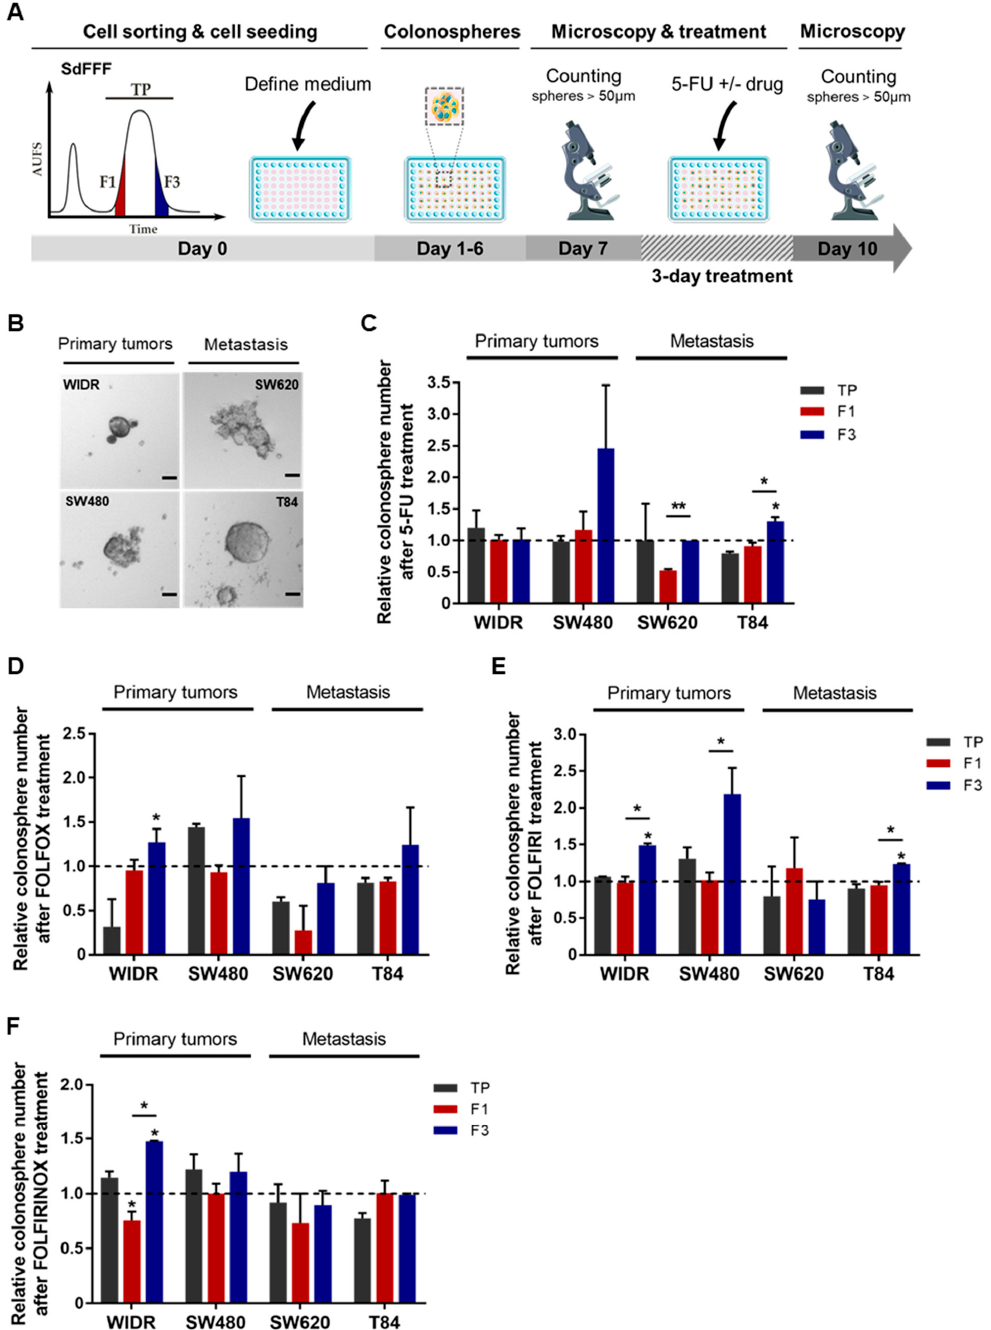
Figure 5. Chemoresistance of F3 colonospheres to 5-FU alone or combined with oxaliplatin and/or irinotecan from CRC cell lines. ( A ) Schematic representation of chemotherapy response analysis performed from colonospheres. SdFFF sorted cell subpopulations are seeded at low density in defined medium for seven days and then treated with chemotherapy for three days. Colonospheres with a diameter larger than 50 µ M were counted before and after treatment. ( B ) The in vitro tumorigenic potential of cells was assessed by a sphere formation assay. Scale bar 50 µ m. ( C – F ) The impact of chemotherapies on CSC tumorigenic properties was analyzed in vitro after treatment with 5-FU alone ( C ), or combined with either oxaliplatin (FOLFOX) ( D ), irinotecan (FOLFIRI) ( E ), or both (FOLFIRINOX) ( F ), compared with the untreated condition (dashed line). All these results are represented as means ± SEM and statistical differences with * p -value < 0.05, ** p -value < 0.01, and * alone for significant results compared to TP using one-way ANOVA